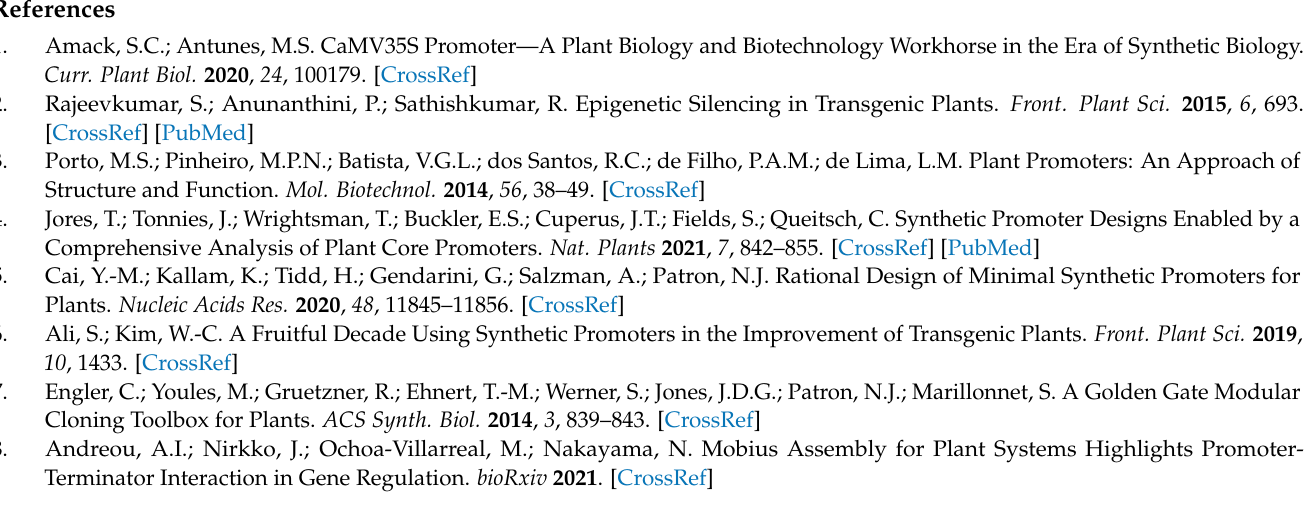
Table S2: Level 0 plasmids with promoters and terminators used in this study; Table S3: Primers